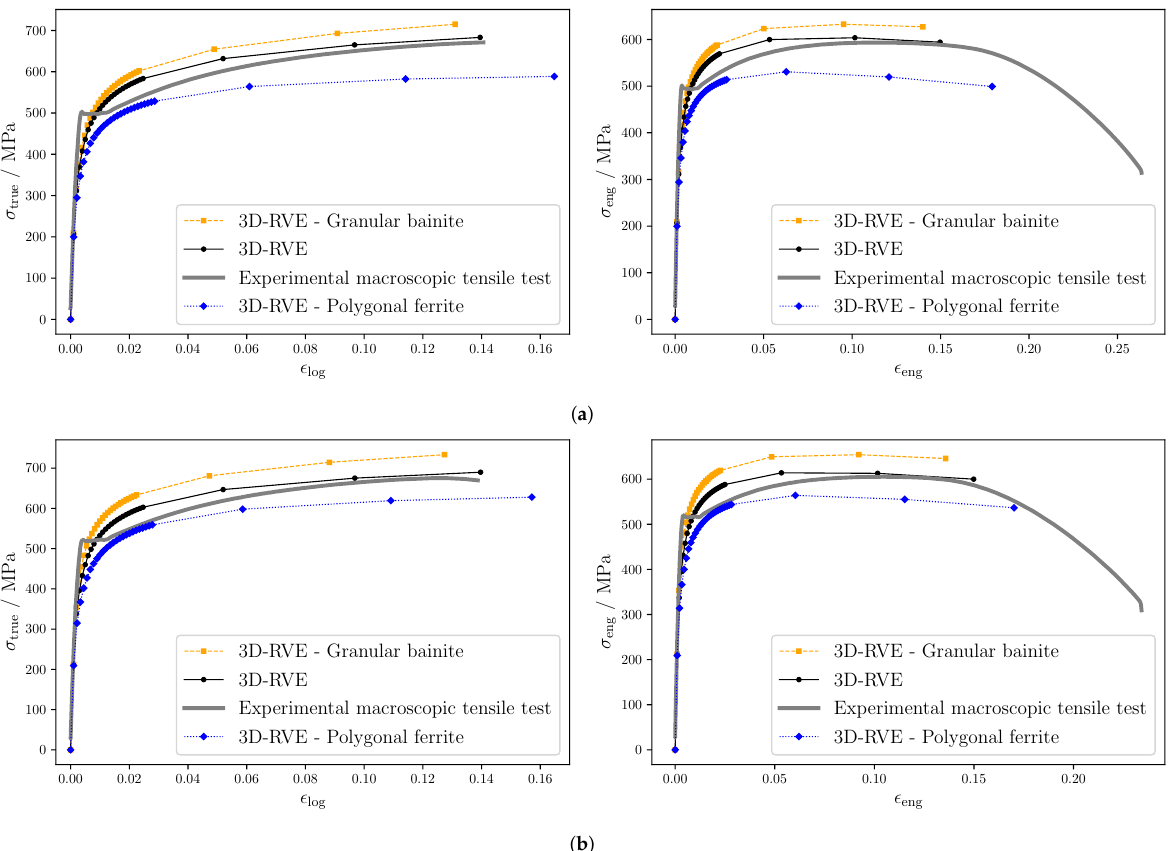
Figure 7. True (left) and engineering (right) stress–strain curves for materials S 1 ( a ) and S 2 ( b ). The simulation results were obtained using a 3D-RVE with the fitted CP parameters of each individ- ual